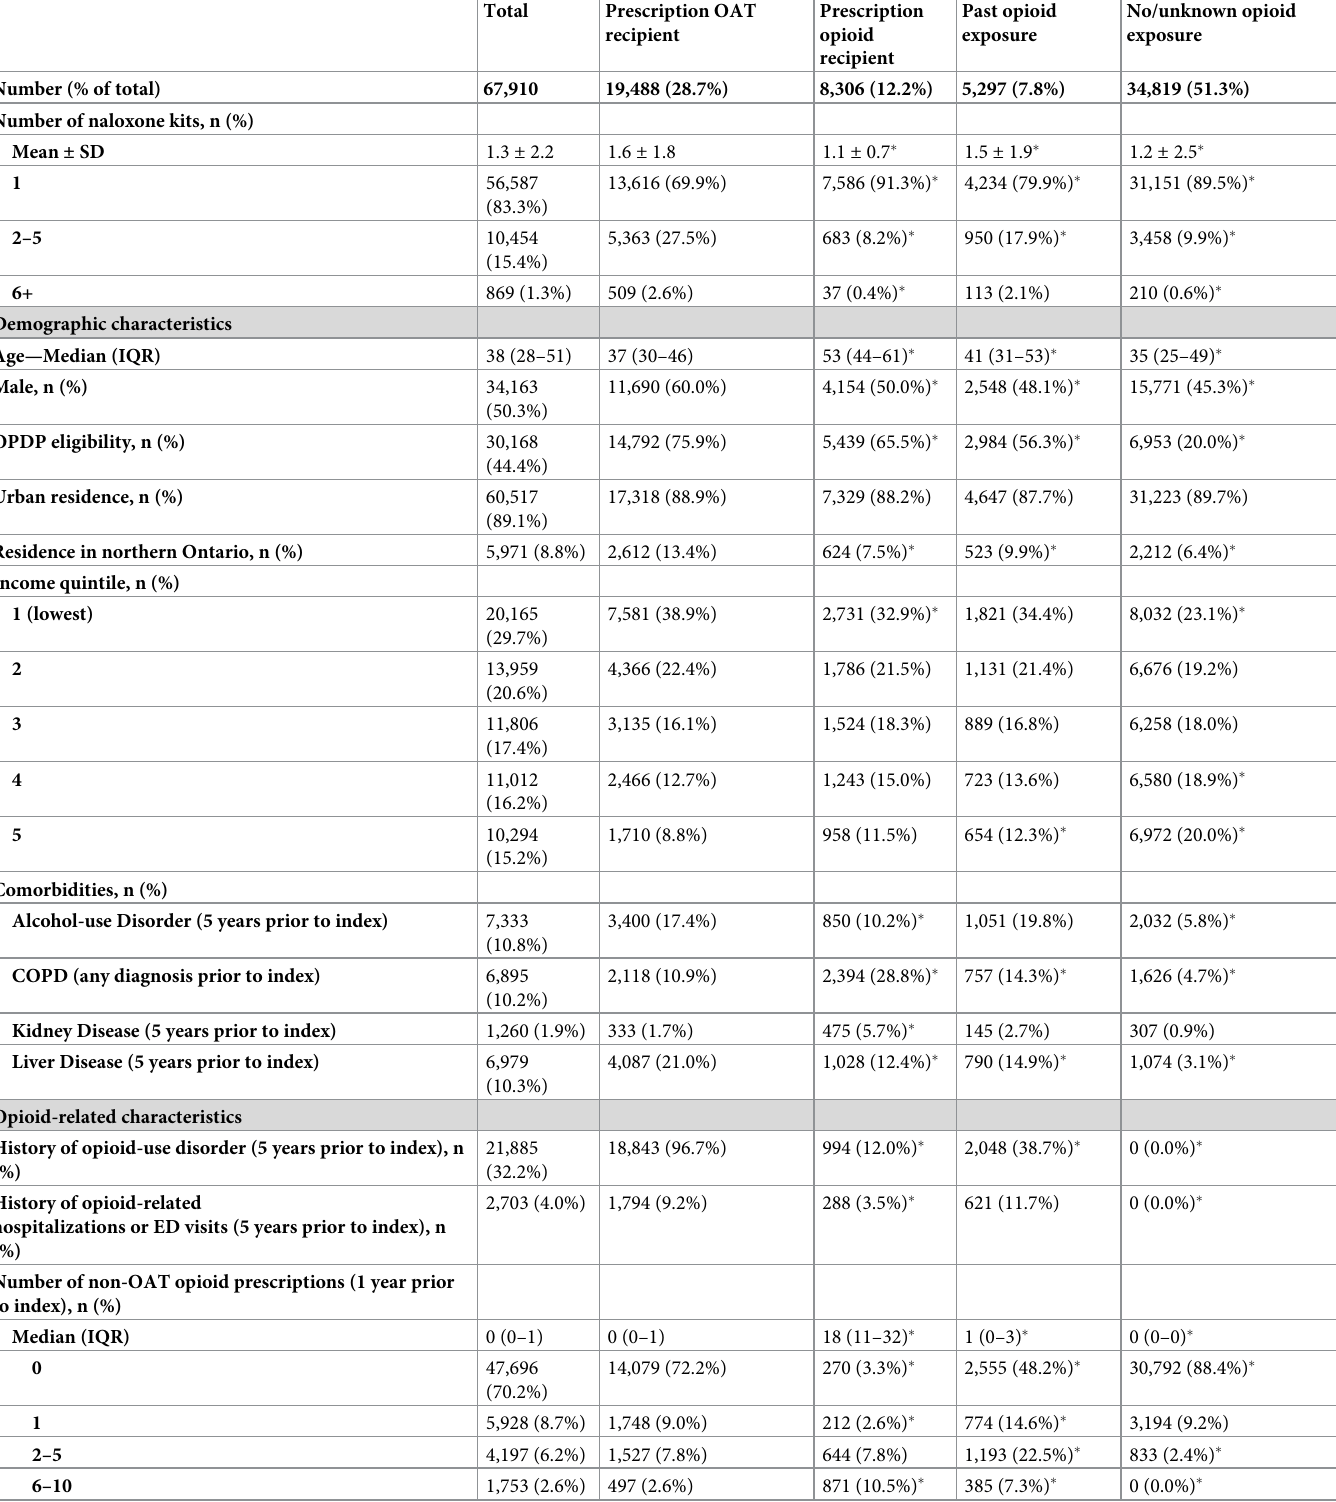
Table 1. Characteristics of individuals who accessed naloxone between July 2016 and March